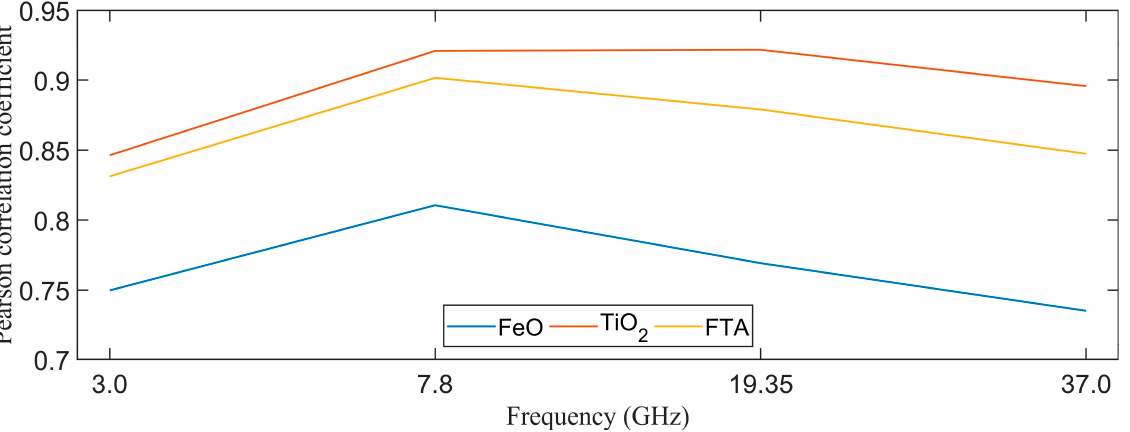
Figure 14. Pearson correlation coefficients between the TBD and the SCREP-based FeO, TiO 2 , and FTA values of the basaltic units mapped by Kramer et al. [2].